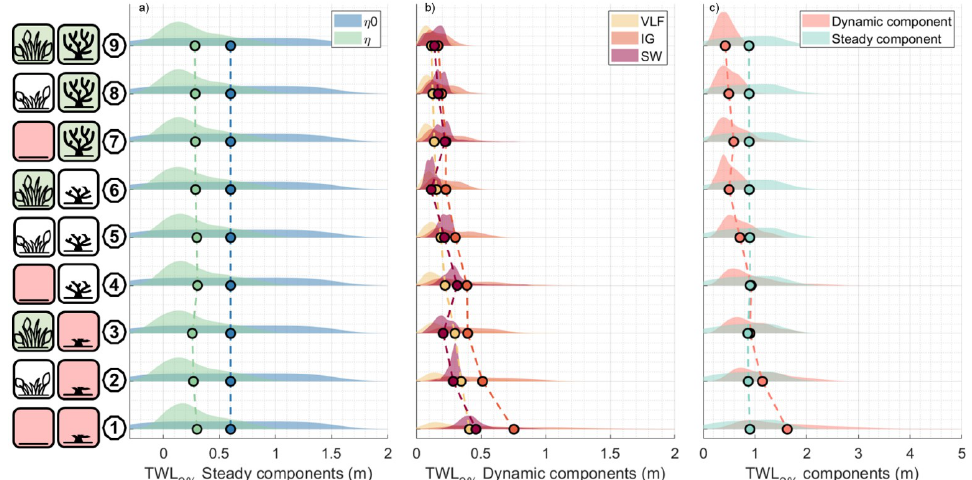
Figure 9. ( a ) Steady components ( η and η 0) of the TWL 2% , ( b ) Dynamic components (SW, IG and VLF) of the TWL 2% , ( c ) Global dynamic and steady components of the TWL 2% . The dots represent the mean for each variable and ecosystem status. The shaded areas represent the distribution for each variable. Each ecosystem configuration is represented, and ecosystem status is indicated by the pictograms on the